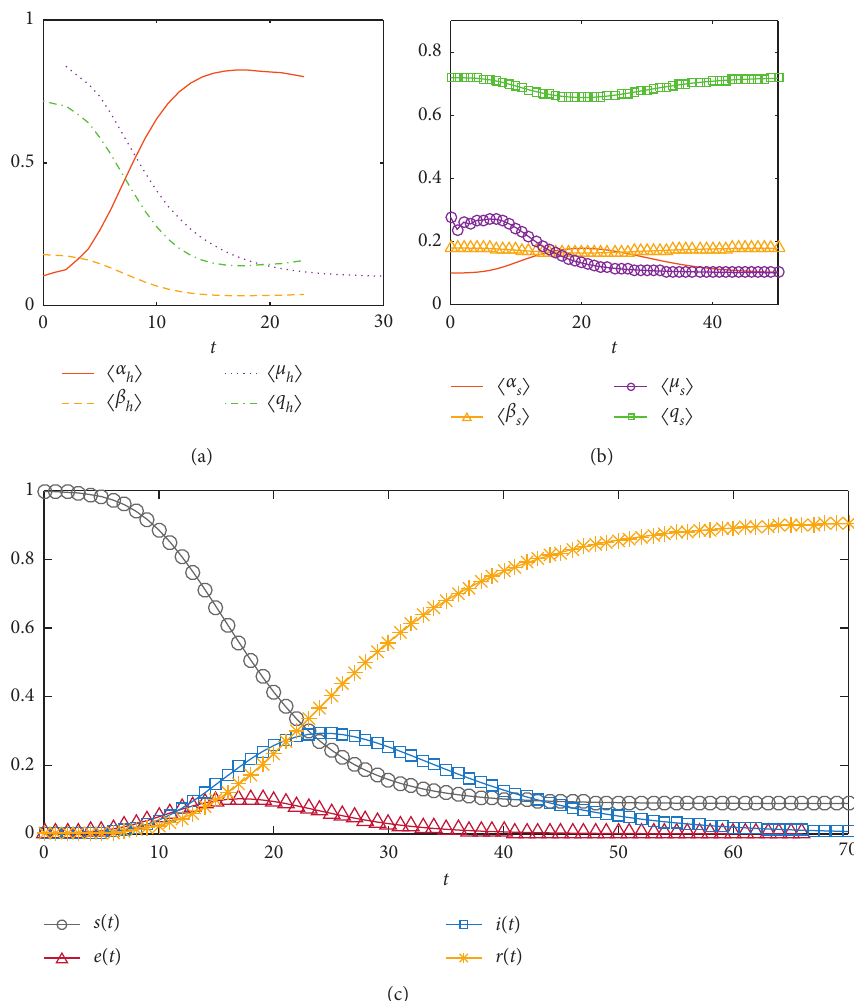
Figure 3: (a) Temporal evolution of average values of awareness 〈 α 〉 (red line), transmission rate 〈 β 〉 (yellow segment), recovery rate 〈 μ 〉 h h h (purple dots), and probability of resource donation 〈 q h 〉 for hub nodes. (b) The evolution of average values of awareness 〈 α s 〉 (red line), infection rate 〈 β s 〉 (yellow triangles), recovery rate 〈 μ s 〉 (purple circles), and probability of resource donation 〈 q s 〉 (green squares) for nodes with small degree. (c) The evolution of the fraction of the nodes in susceptible s ( t ) , exposed e ( t ) , infected i ( t ) , and recovered r ( t ) states, respectively. The instinctive self-awareness is α � 0 . 1, and the basic infection rate is β � 0 . 2. The other parameters are the same as those in Figure 2. The results of the simulations are obtained by averaging over 10 2 × 10 2 independent realizations on 10 2